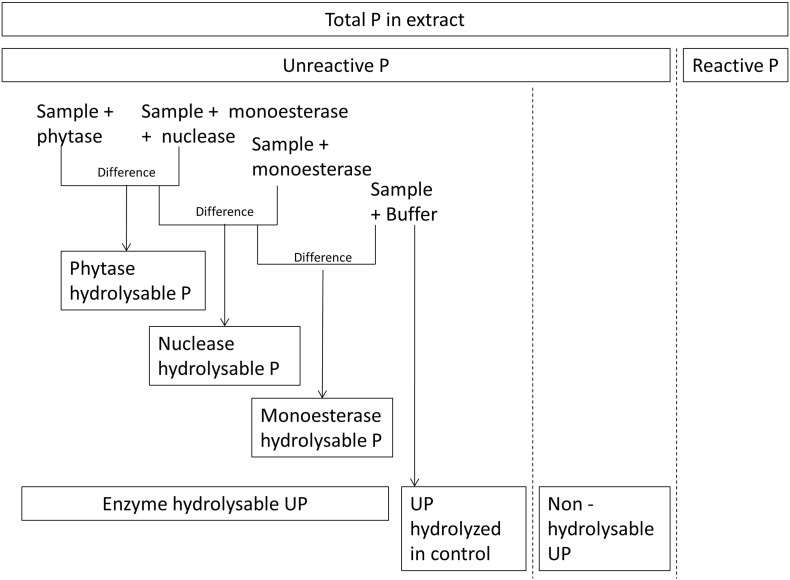
Schematic demonstrating how forms of unreactive phosphorus (UP) in a sample extract may be quantified using the phosphatase hydrolysis method. Subsamples are incubated with phosphatase enzymes, or a buffer as a control, and differences in the concentration of reactive phosphorus corresponds to the quantity of the UP hydrolyzed.